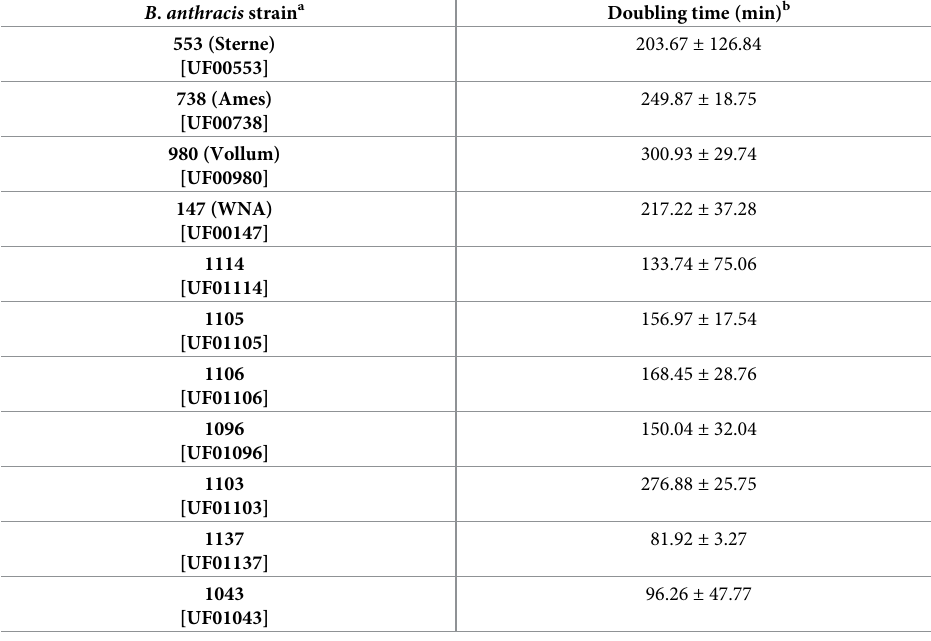
a Strains in blue are lab strains and red are wild strains. Parenthesis indicate common names of lab strains. b Data are culture doubling time in minutes calculated from the OD 600 values plus or minus the SD of the replicate growth numbers from the beginning and end of exponential